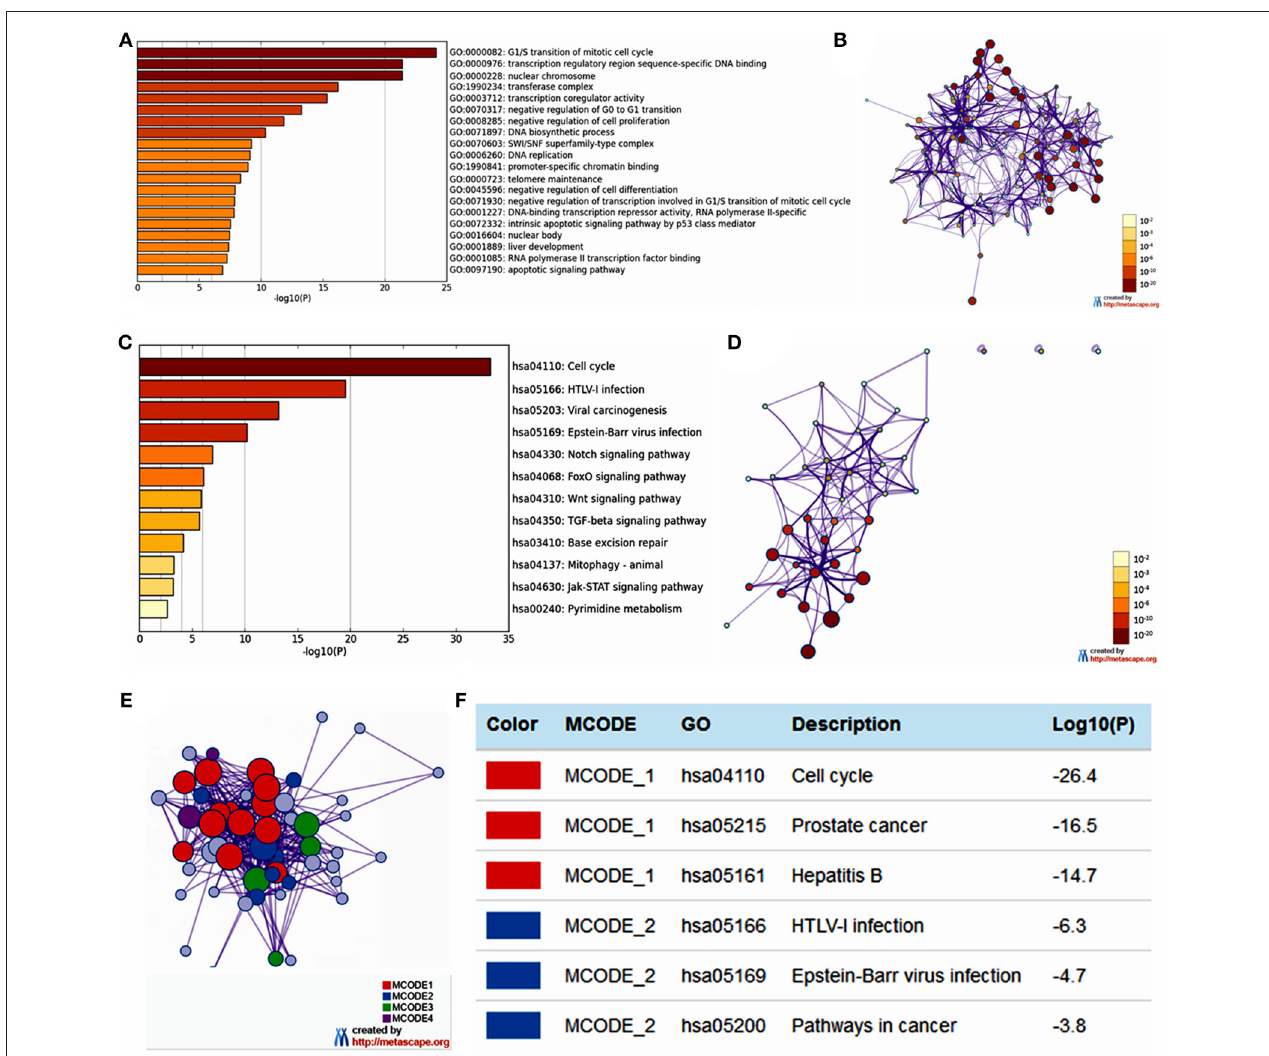
FIGURE 6 | The enrichment analysis of E2F family members and neighboring genes in OC (Metascape). (A) Heatmap of Gene Ontology (GO) enriched terms colored by p -values. (B) Network of GO enriched terms colored by p -value, where terms containing more genes tend to have a more significant p -value. (C) Heatmap of Kyoto Encyclopedia of Genes and Genomes (KEGG) enriched terms colored by p-values. (D) Network of KEGG enriched terms colored by p -value, where terms containing more genes tend to have a more significant p -value. (E) Protein–protein interaction (PPI) network and four most significant MCODE components form the PPI network. (F) Independent functional enrichment analysis of three MCODE